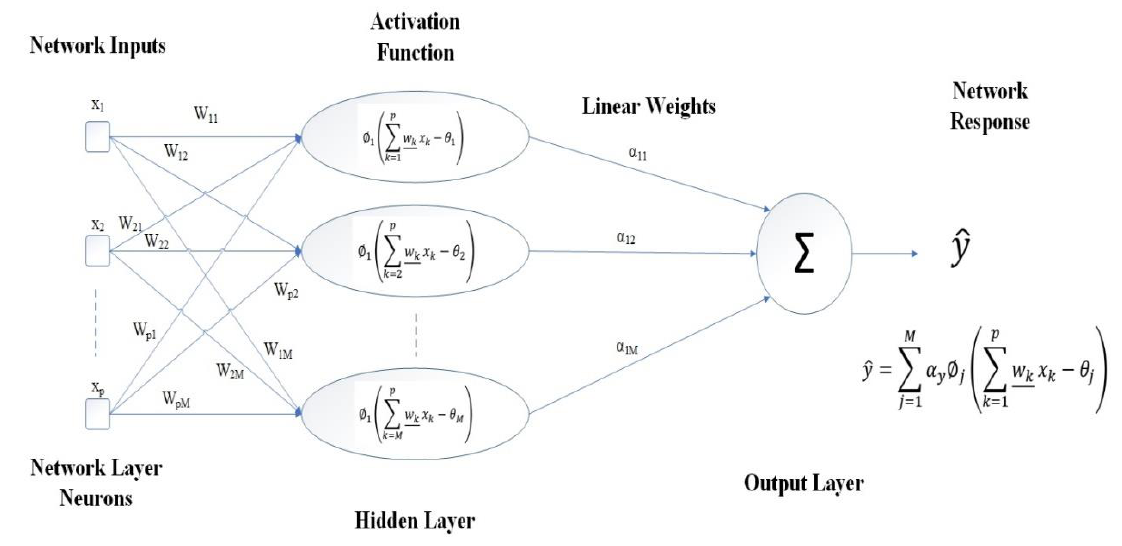
Figure 15. Flowchart of typical single line hidden layer MLP for identifying a problem.